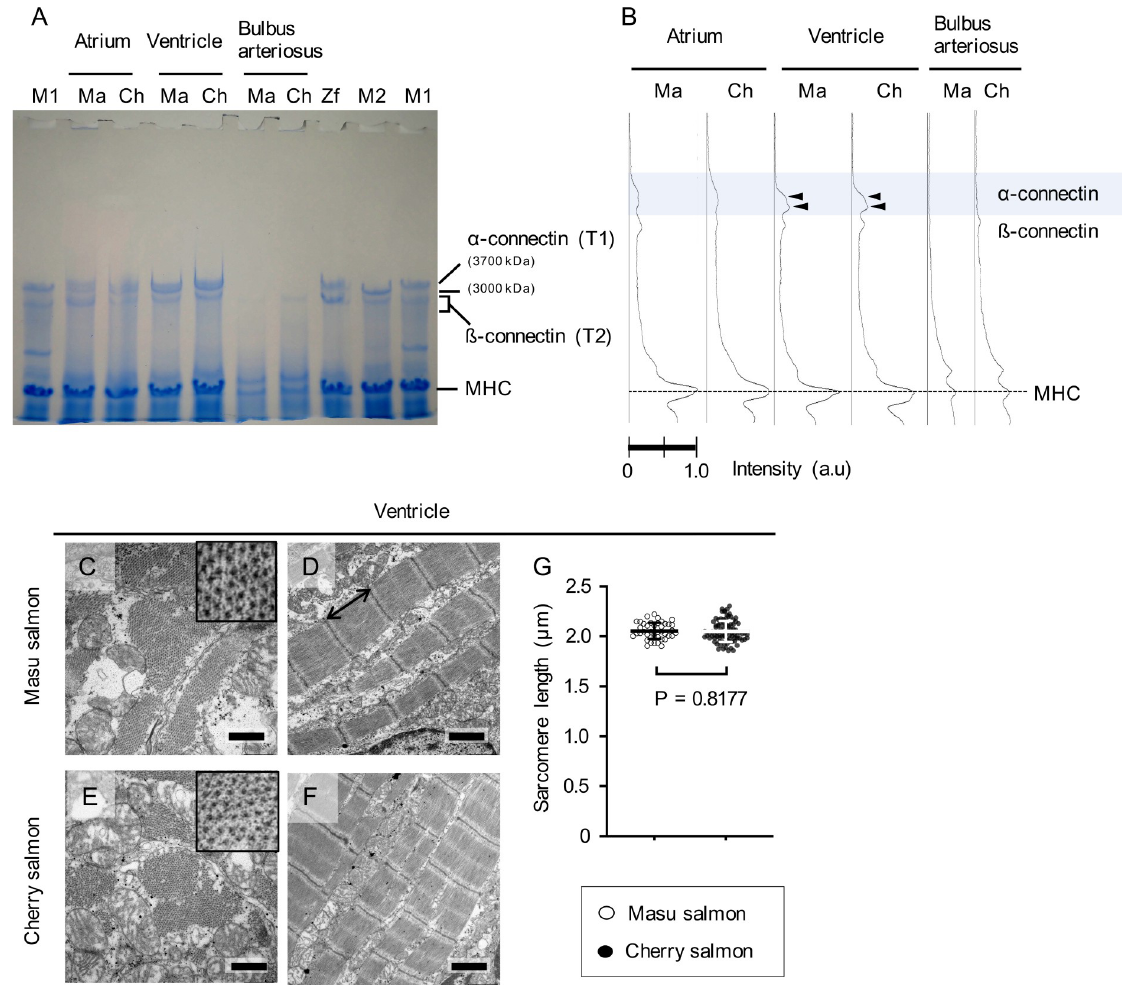
Fig 5. Molecular weights of the Connectin isoforms and sarcomere lengths in the hearts of masu and cherry salmon. (A) A representative CBB-stained gel image. Lanes 2–7 show the molecular weights of Connectin isoforms in the atrium, ventricle, and bulbus arteriosus of masu salmon (Ma) and cherry salmon (Ch). The following samples were used as molecular weight standards: a major Connectin isoform in zebrafish heart (Zf, 3500 kDa) in lane 8; Connectin N2A isoform from the skeletal muscles of mice (M1, 3700 kDa) in lanes 1 and 10; the Connectin N2B isoform expressed in the left ventricle of mice (M2, 3000 kDa) in lane 9. α -connectin (T1) and β - connectin (T2) indicate an intact Connectin and its degraded product, respectively. MHC indicates Myosin heavy chain (molecular weight ~220 kDa each), which was used as a loading control. (B) Electropherogram of lanes 2–7 of the CBB-stained gel in (A). Black arrowheads indicate the band peaks for the ventricles of masu and cherry salmon in the α -connectin zone. (C–F) Representative transmission electron microscopy images of the cross-sections and longitudinal sections in the ventricular sarcomeres of masu and cherry salmon 29 months post fertilization. Insets of (C, E) showing higher magnification images of the cross-sections of myofibril bundles. Scale bars = 500 nm in (C) and (E) and 1 μ m in (D) and (F). (G) The ventricular sarcomere lengths of the z-line to z-line in the ventricles of masu salmon (2.06 ± 0.08 μ m, N = 42) and cherry salmon (2.05 ± 0.11 μ m, N = 90). A black double arrow indicates sarcomere length. Lines and error bars indicate the means ± standard deviations. � : masu salmon, ● : cherry salmon. A raw data image of CBB-stained gel is found in S1 Raw images. Minimal data sets for (G) are found in S5